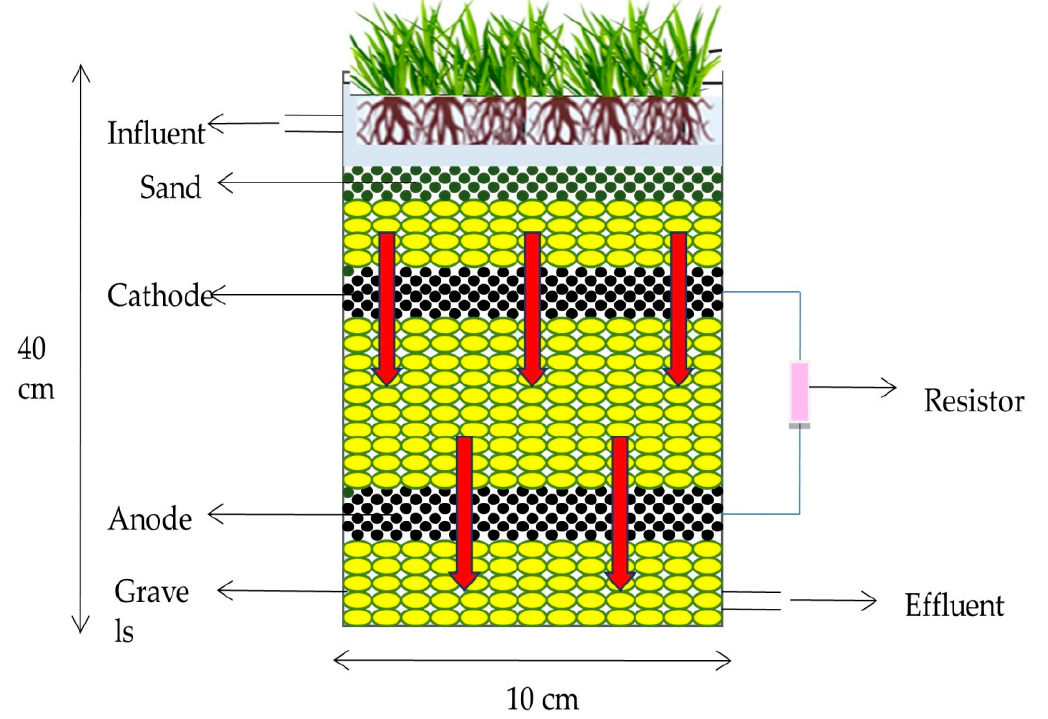
Figure 6. Constructed wetland microbial fuel cell (vertical subsurface flow).